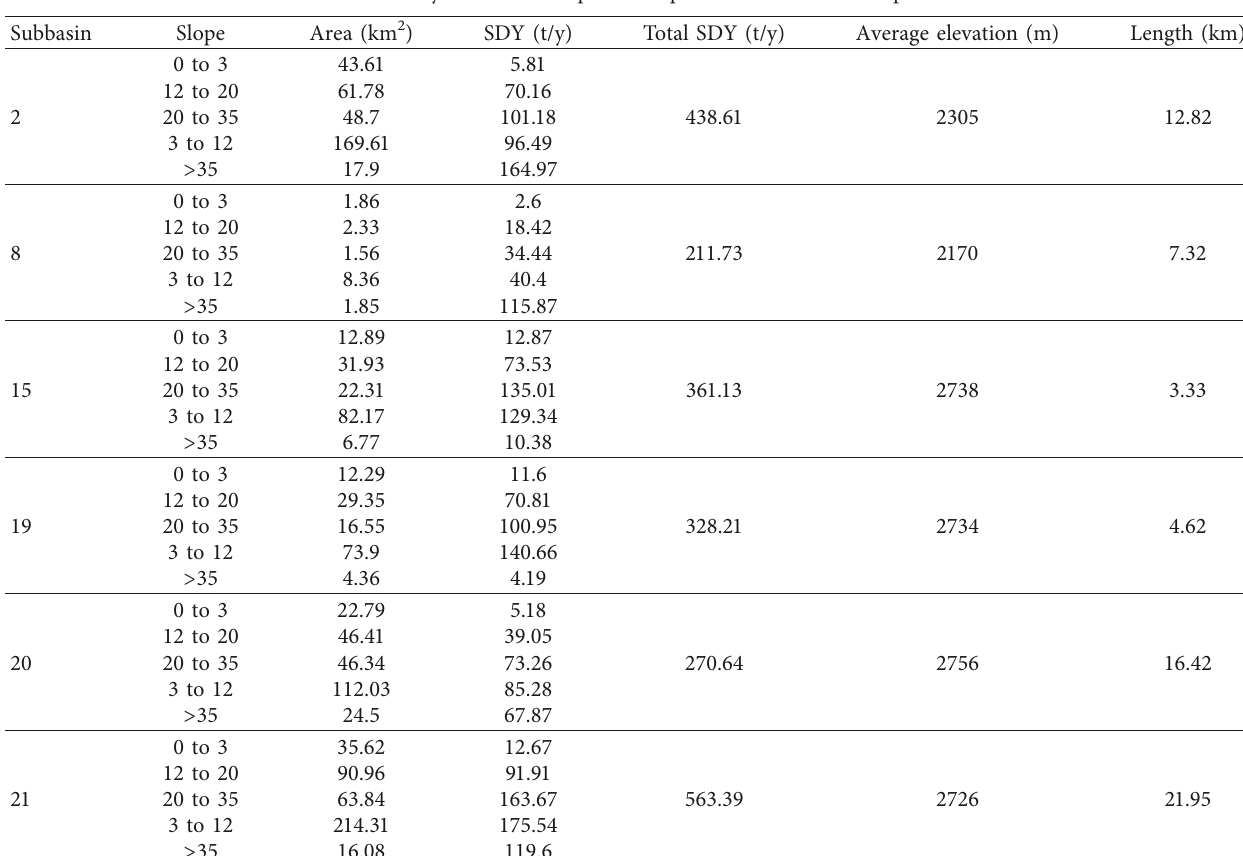
Table 11: Sediment yield relationship with slope and elevation in hotspot subbasin.